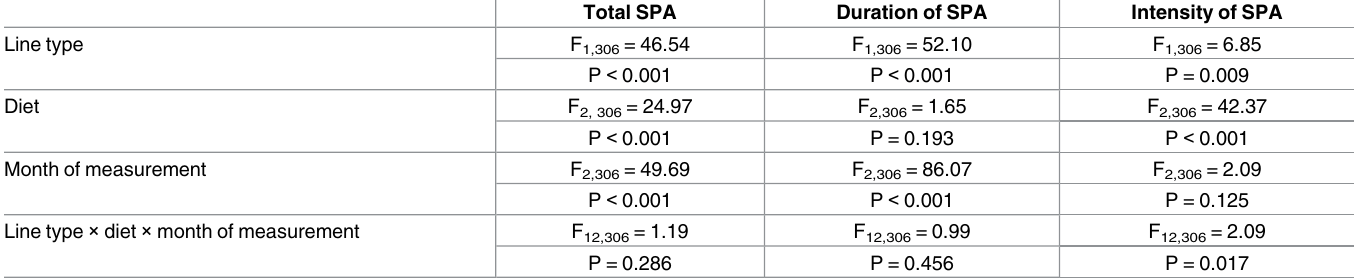
Table 2. Repeated measuresANOVA results of all three estimatesof SPA recorded at the end of the experimental months in H-BMR and L-BMR mice fed a HFat, HCarb and Control diet.